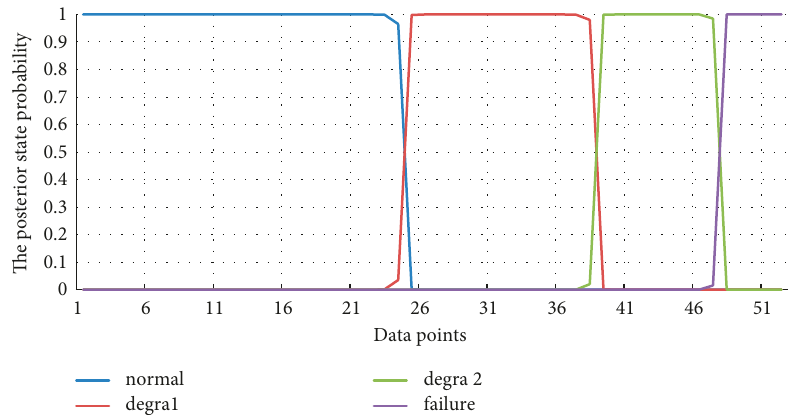
Figure 12: The posterior probabilities of hidden states. Table 4: Transfer probability of the CRDM. Table 5: The comparison between the proposed method and HMM method (unit: